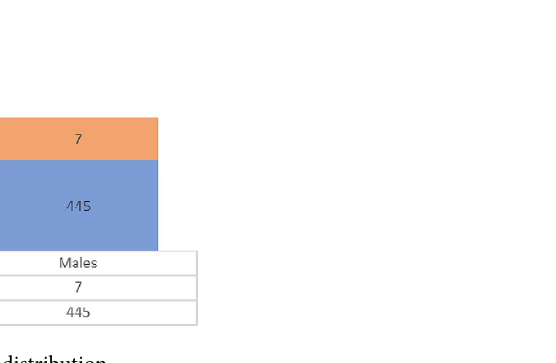
Figure 2. IgG and IgM antibodies and sex